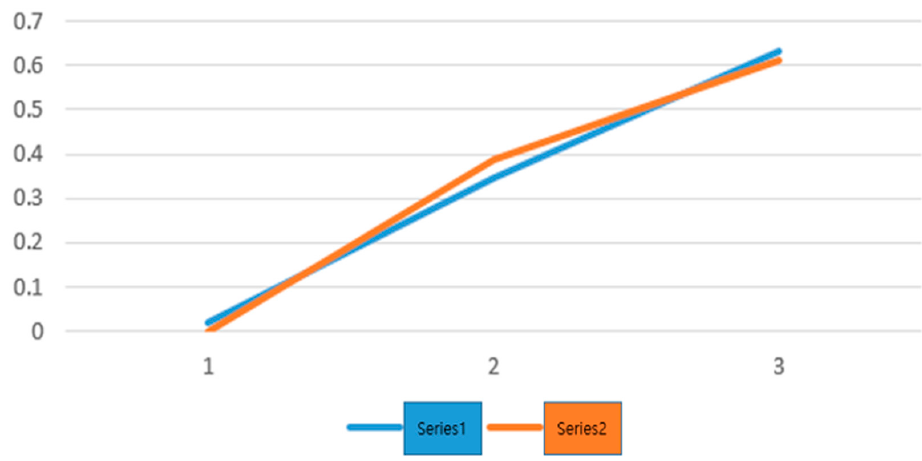
Figure 16. Comparison between the appearance frequency of “tropical night” and maximum power (“Living Culture” section of Naver news, 2016).